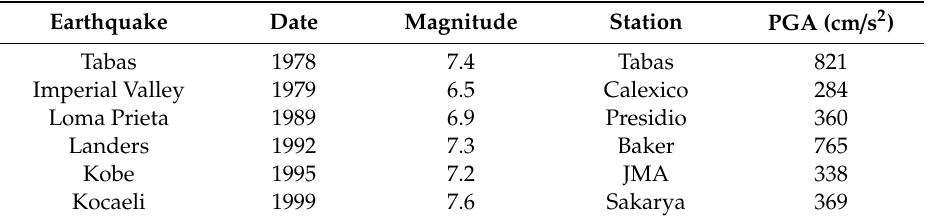
Table 1. The properties of earthquake records used in the analysis. Earthquake